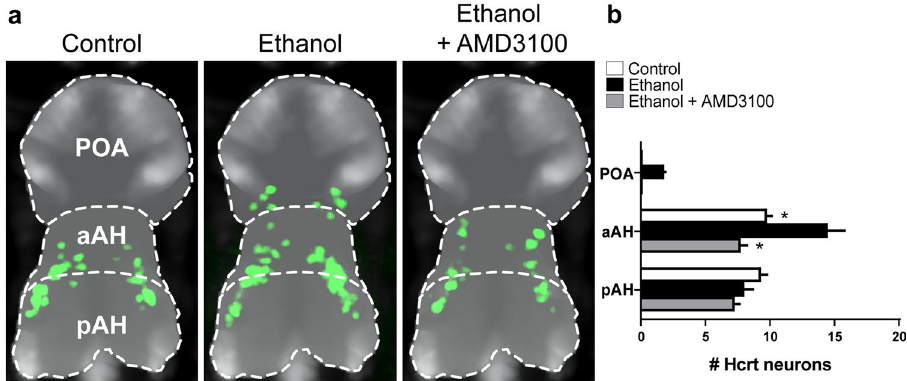
Figure 2. Effects of exposure to embryonic ethanol (0.5% v/v, 22–24 hpf) and Cxcr4 antagonist AMD3100 (1 µM, 2–24 hpf) on the location of Hcrt neurons in the aAH, pAH and POA of 6 dpf zebrafish brains. ( a ) Photomicrographs (×25, overlay of n = 4 images in each condition) illustrate zebrafish brains, in a dorsal/ ventral view obtained at 6 dpf using live-imaging, with pan-neuronal vglut2a expression (grey) and also Hcrt neurons (green) normally located in the aAH and pAH of control, ethanol, and ethanol + AMD3100 zebrafish and ectopically located in the POA of only ethanol zebrafish. ( b ) Bar graphs (n = 4/group) show that ethanol compared to control increases the number of Hcrt neurons in the aAH and induces ectopic neurons in the POA while having no effect in the pAH, and these effects on Hcrt neurons in the aAH and POA are totally blocked by AMD3100. Scale bar 20 µm. * p < 0.05 compared to ethanol. Results are shown as means ± standard errors. aAH anterior part of the anterior hypothalamus, pAH posterior part of the anterior hypothalamus, POA